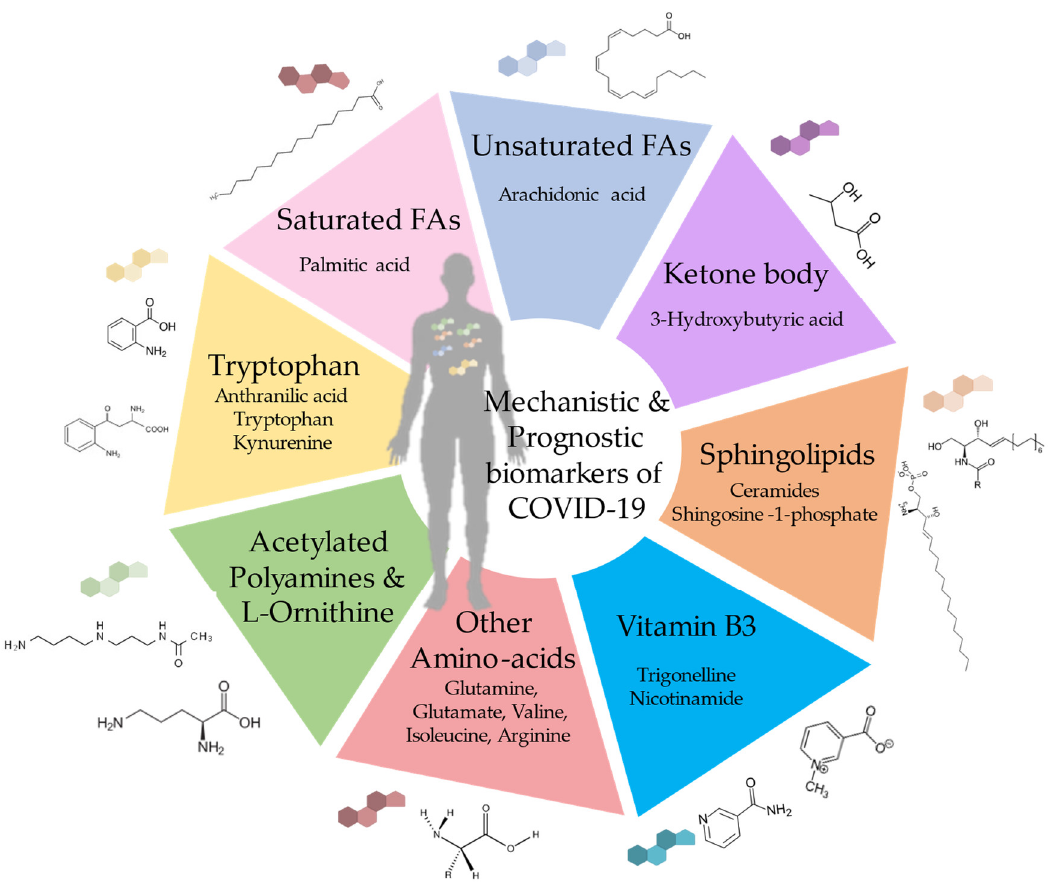
Figure 2. Mechanistic, diagnostic and prognostic biomarkers of COVID-19 disease.